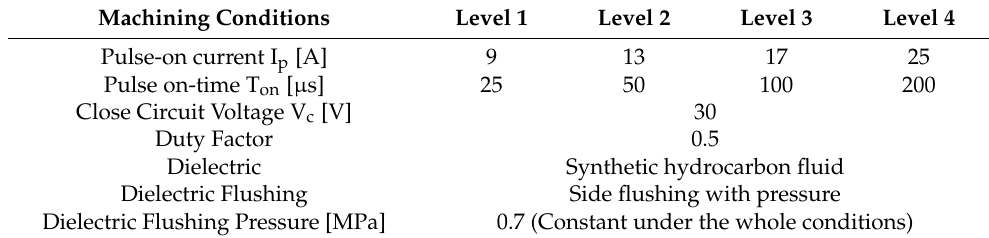
Table 3. Machining